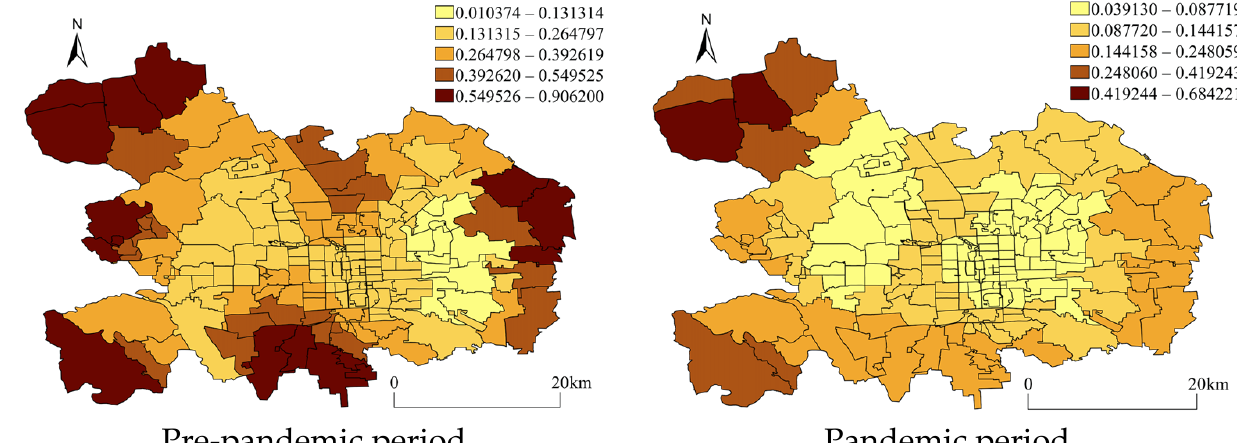
Figure 5. Coefficients of gym rooms from GWR with residential burglary. The coefficients were categorized by using natural breaks.